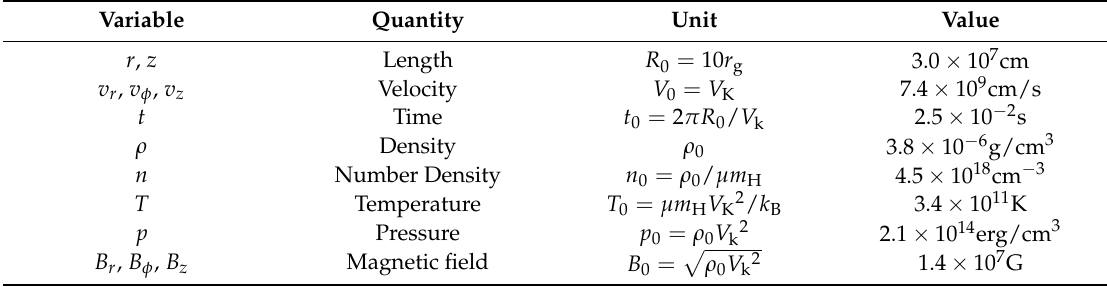
Table 1. Normalization